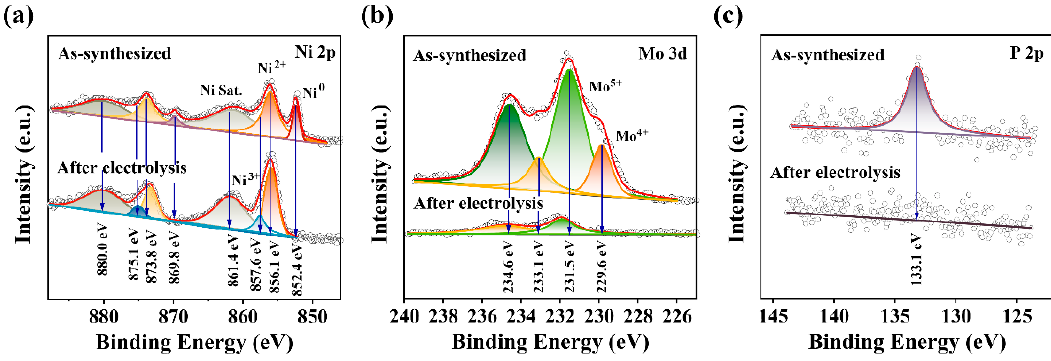
Figure 3. XPS spectra of ( a ) Ni 2p, ( b ) Mo 3d, and ( c ) P 2p for NiMoP/NF.